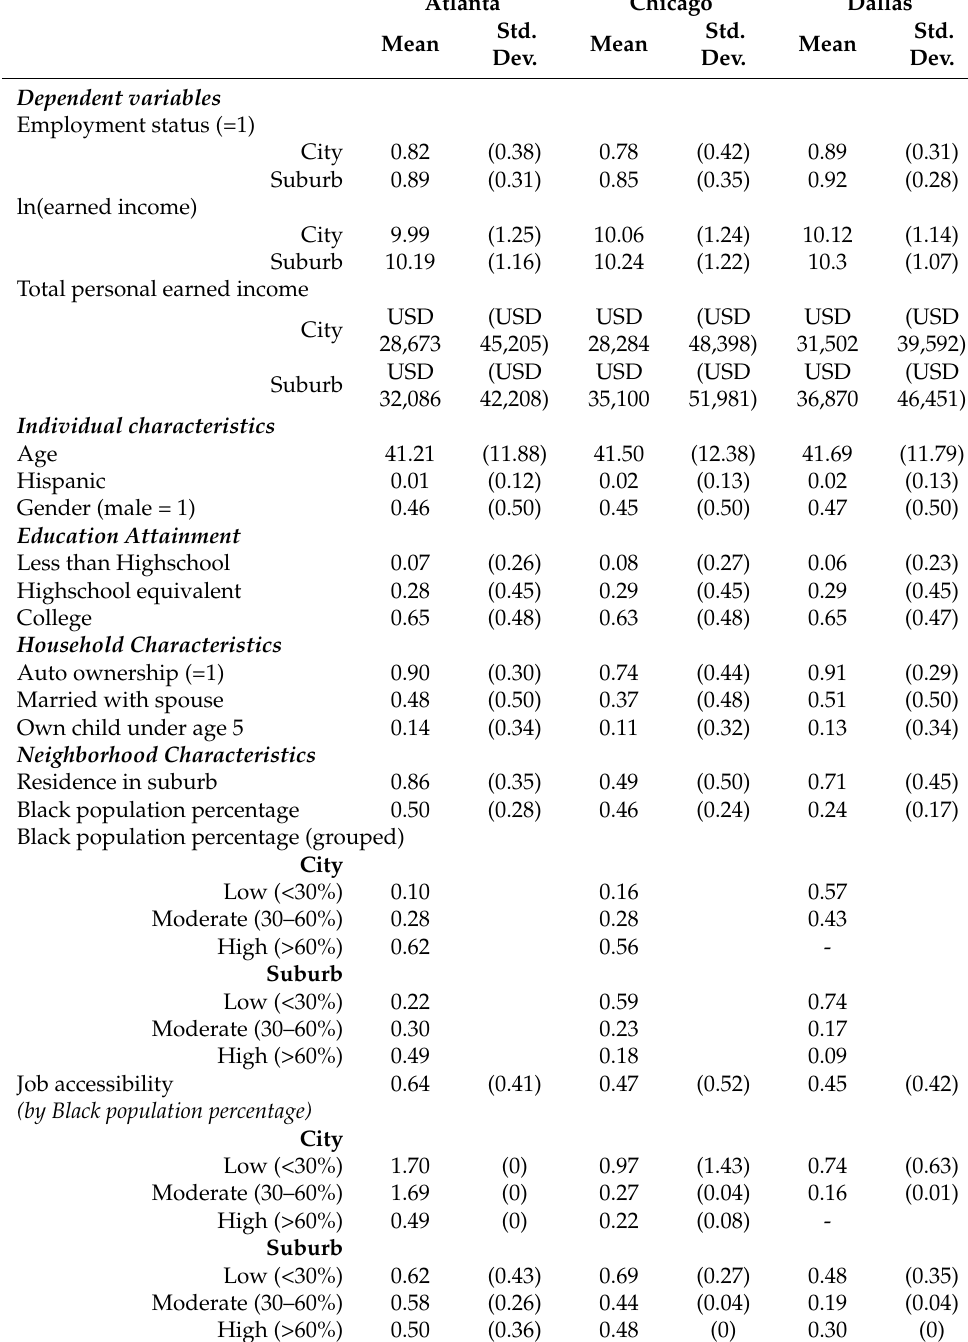
Table 1. Descriptive statistics of variables in the city and the